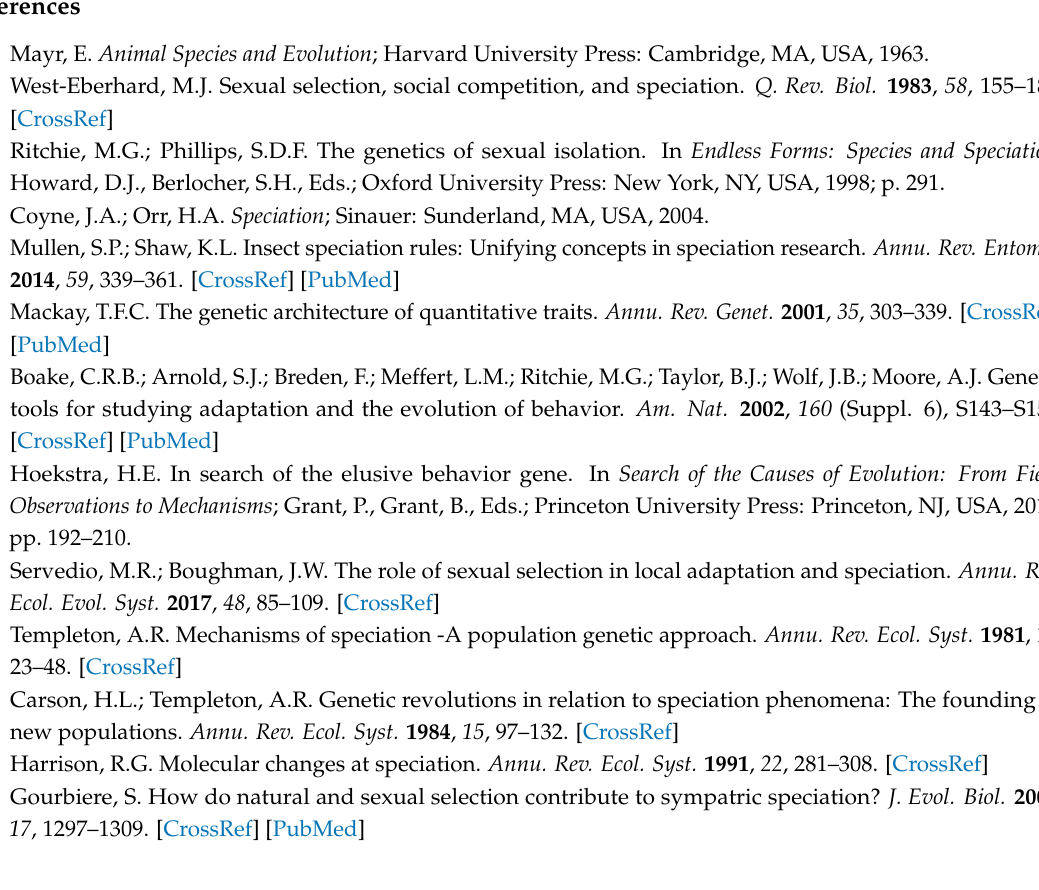
Figure S1: Linkage map and multivariate QTL model results, Figure S2: Inversion on LG1, Table S1: QTL dominance effects, Table S2: QTL peak and flanking markers, Table S3: Annotated transcripts mapping to QTL regions after correcting for pseudo-replication, Table S4: GO enrichment of transcripts in Table S3, Table S5: GO enrichment of transcripts in Table S3 per linkage group, Table S6: Annotated transcripts mapping to QTL regions without correcting for pseudo-replication, Table S7: GO enrichment of transcripts in Table S6, Table S8: GO enrichment of transcripts in Table S6 per linkage